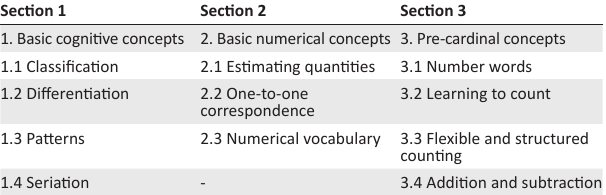
TABLE 1: Contents and structure of Meerkat